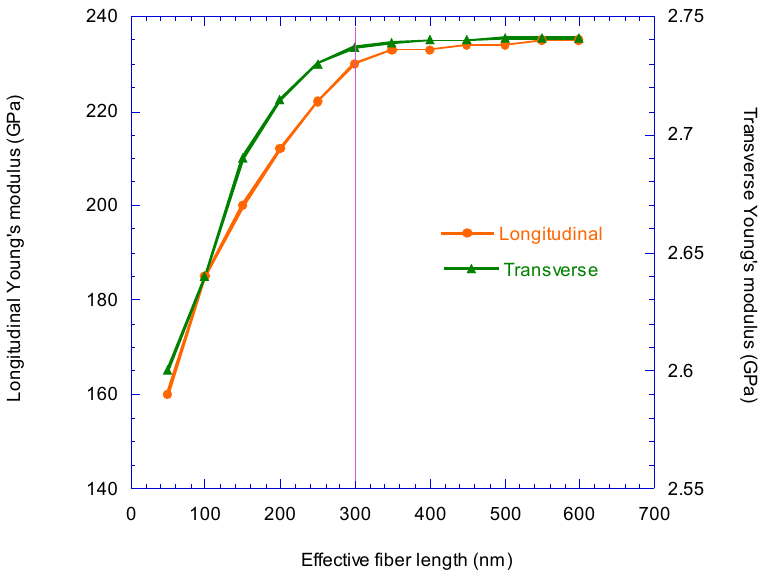
Figure 9. Variation in the longitudinal and transverse Young’s modulus with respect to the change in EF length.